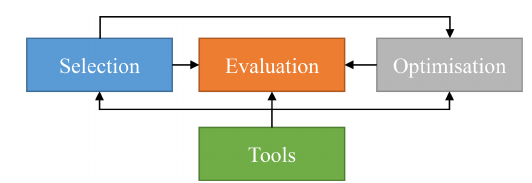
Figure 4. Evaluation process of nature-based solutions. The process includes selecting possible measures and evaluating and optimising measures’ performance using available